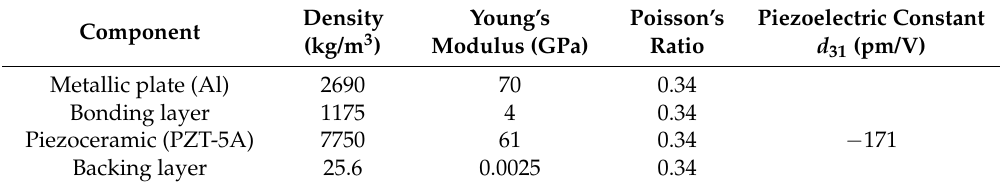
Table 1. Material properties of the multilayered structure [25].